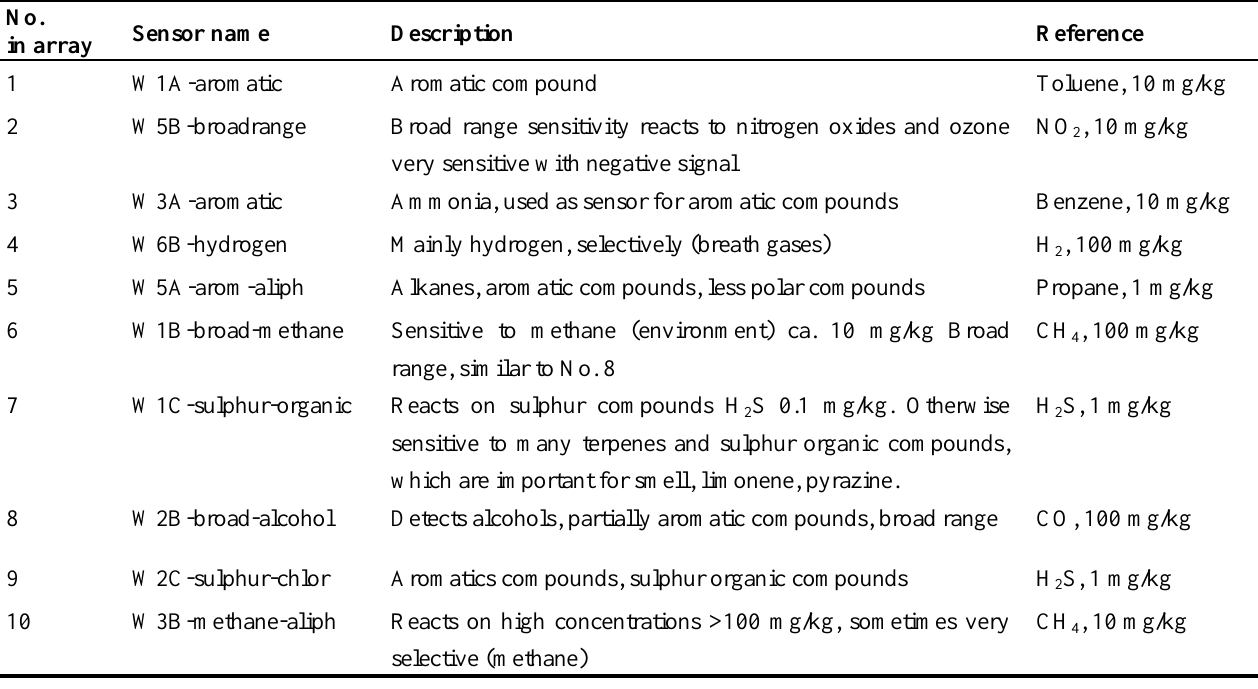
Table 1. MOS Sensor Array of PEN2 and their main